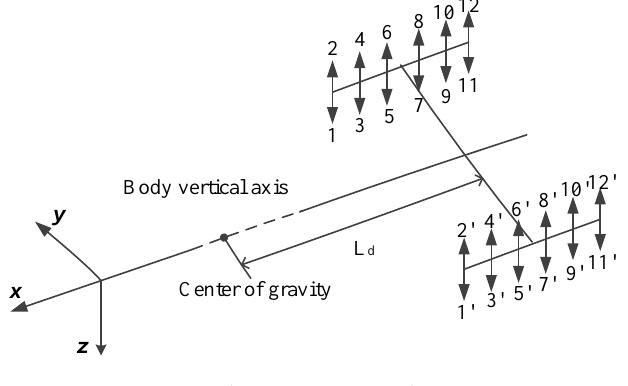
Figure 5. Thruster positions diagrams.